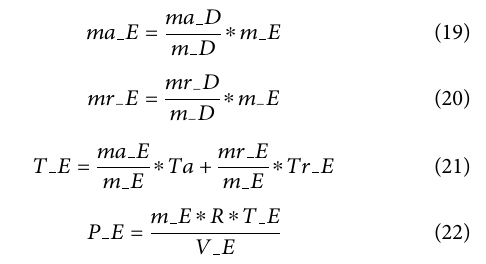
FIGURE 2 Schematic diagram of the 6EX340EF diesel engine model structure.